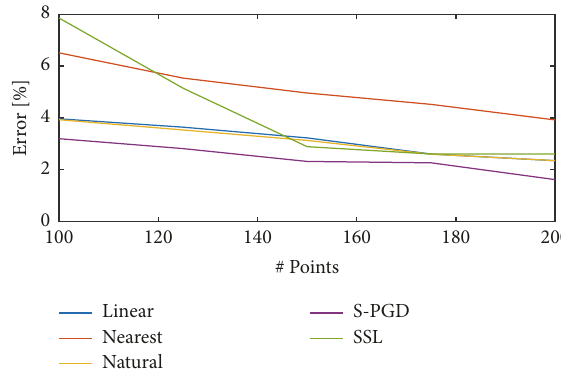
Figure 11: E L of 𝑢(𝑥,𝑡) varying # P for different identification techniques. # L = 1000 . 𝜖 𝑟 = 2.5 ⋅ 10 −3 .